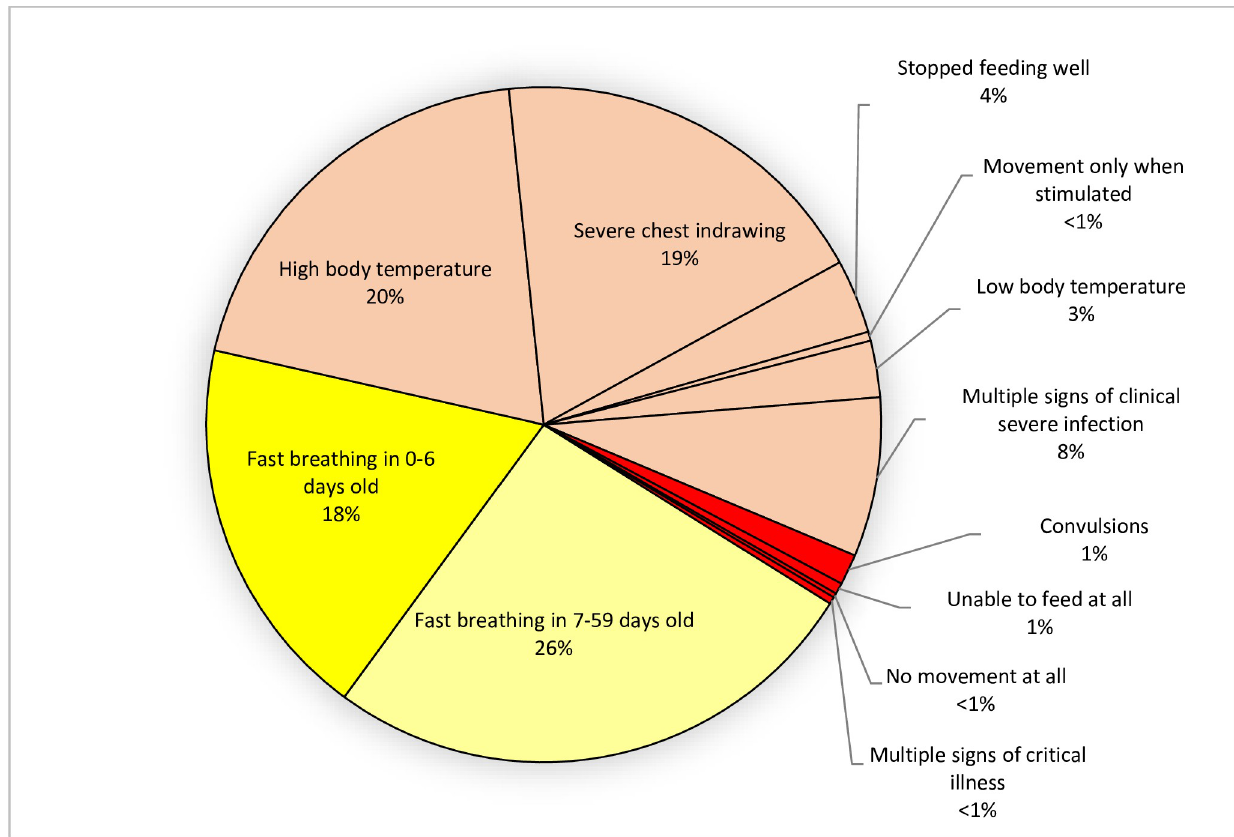
Fig 1. Prevalence of clinical signs of possible serious infection in young infants 0–59 days old (n = 7129).